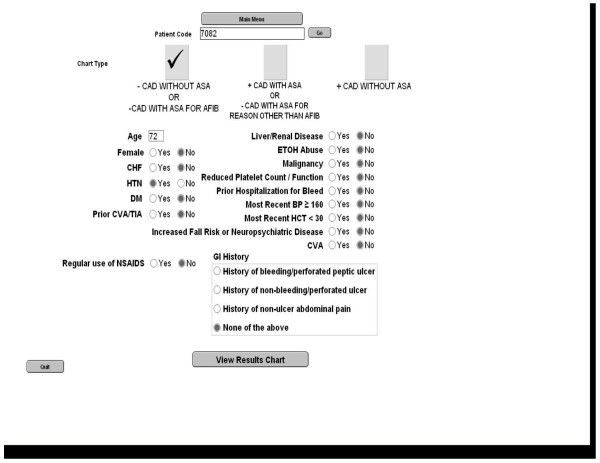
Data entry screen.